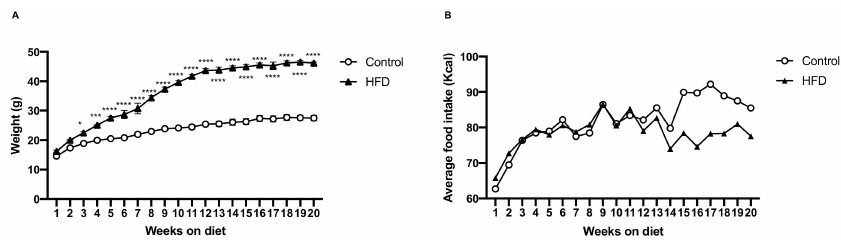
Figure 1. Dietary-induced changes in body weight and food intake. ( A ) After 20 weeks, high-fat diet (HFD) mice had significantly more body weight gain. ( B ) The two groups of mice with ad libitum food access had similar caloric intakes. The asterisks denote the level of statistical significance calculated using a two-way analysis of variance (* p < 0.05, *** p < 0.001, **** p < 0.0001); data are represented as means ( n = 30 in each group). HFD: high fat